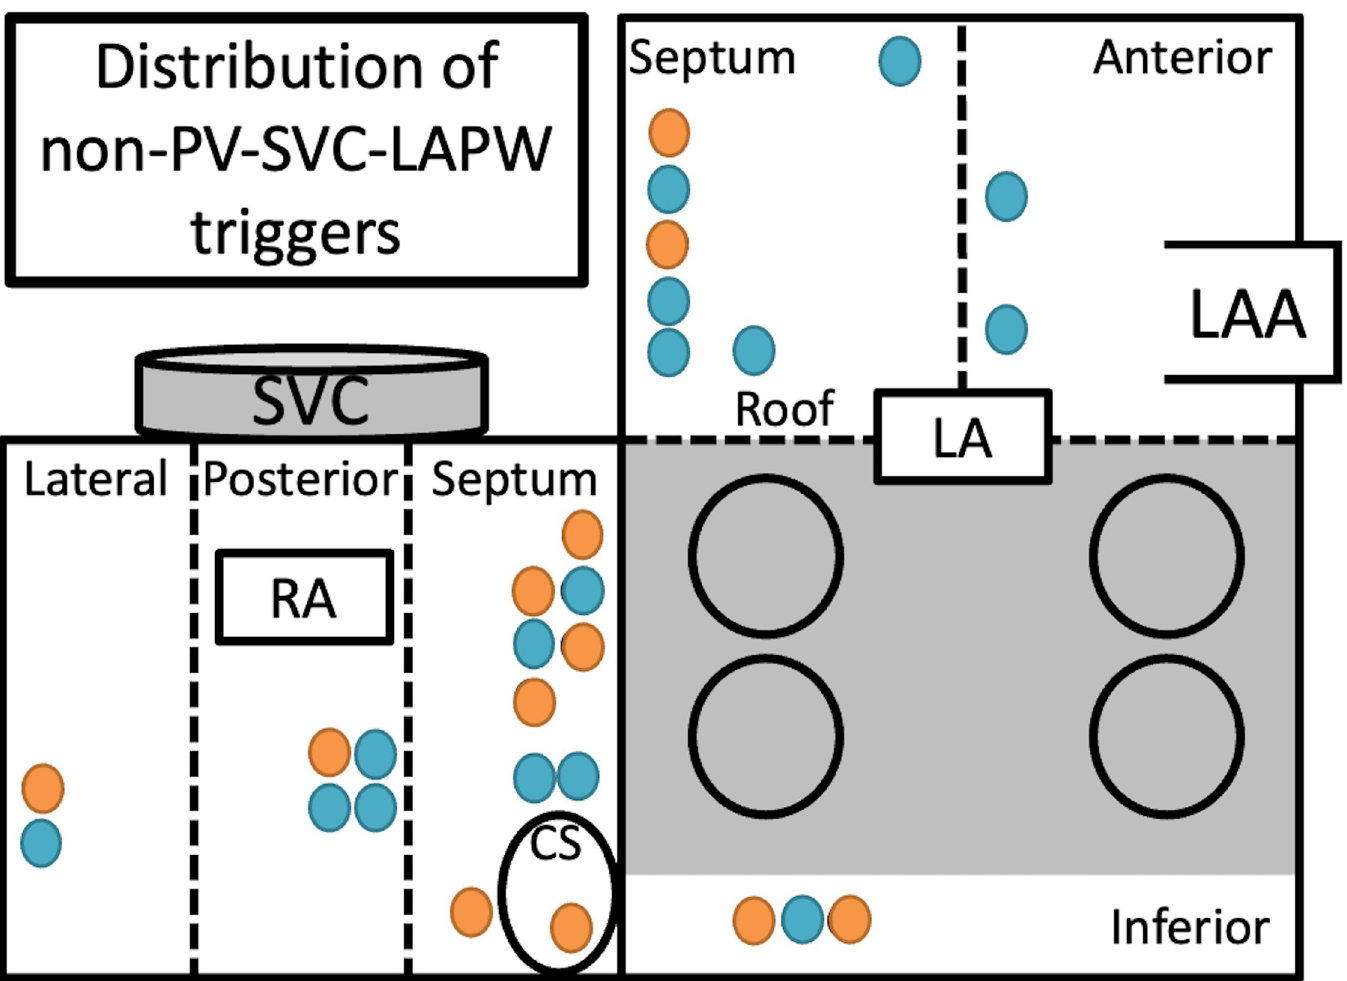
Fig 2. The distribution of non-PV-SVC-LAPW triggers. Blue tag indicates normal sinus voltage. Orange tag indicates low sinus voltage. CS = coronary sinus; PV = pulmonary vein; LA = left atrium; RA = right atrium; LAA = left atrial appendage.